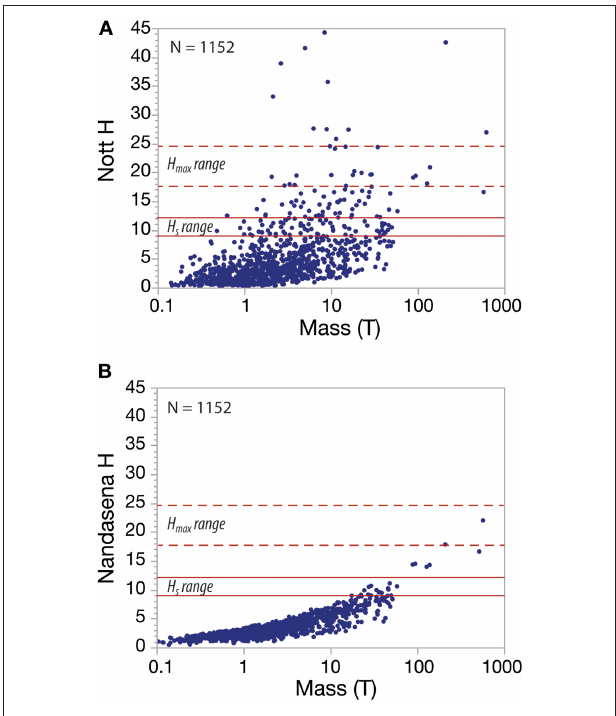
FIGURE 6 | Raw hindcast wave heights for the Aran Islands in winter 2013-2014, plotted as a function of boulder mass. (A) shows results from the original Nott (2003b) formula (Equation 9), and (B) shows those from the variant based on Nandasena et al. (2011b) (Equation 10). Red horizontal lines show the range of H s (solid red: model outputs from Figure 5 ) and H max (dashed red: estimated as 2 H s ). The largest waves in (A) are not associated with the largest boulders because of the shape dependency built into the Nott (2003b) equation, which predicts that slab-like boulders will be more difficult to move. The Nandasena-based version has a different shape dependency. The original Nott equations return wave heights up to 45m, whereas those from the Nandasena-based equations are generally significantly